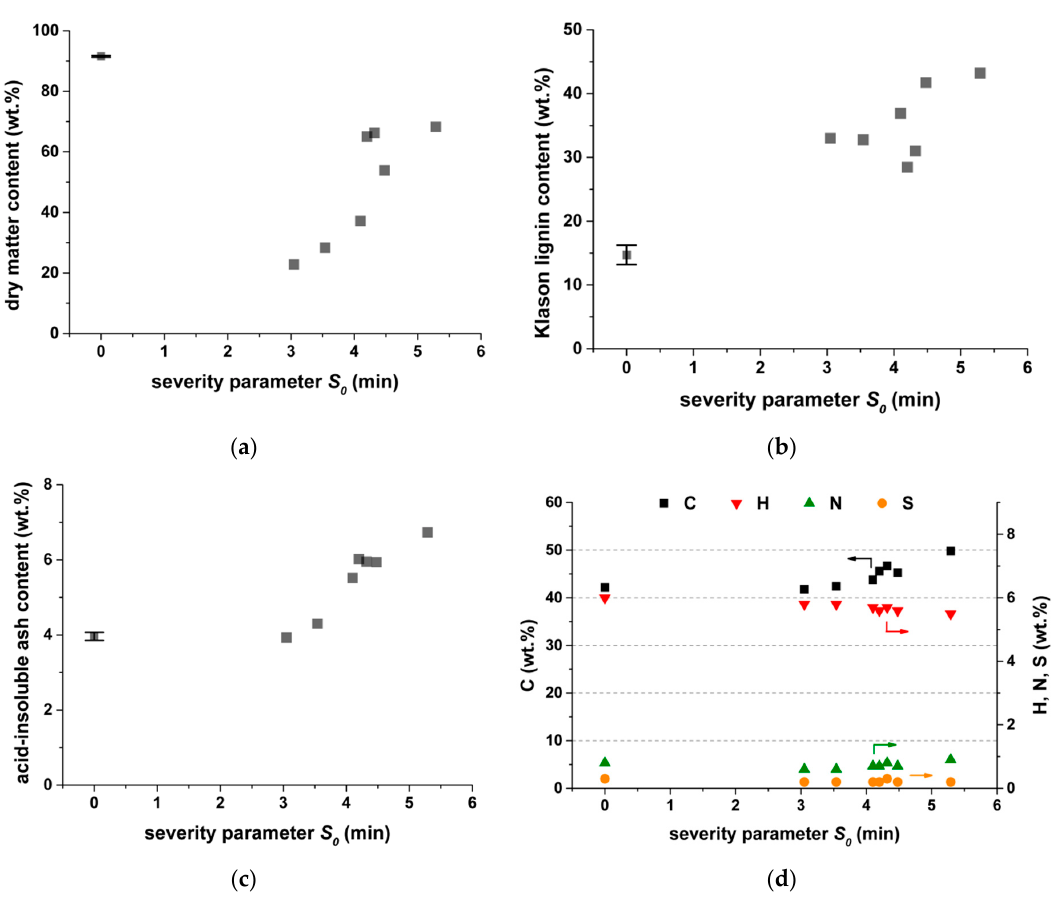
Figure 2. Chemical composition of untreated and pretreated rice straw depending on the severity parameter S 0 of the steam explosion, ( a ) dry matter content, ( b ) Klason lignin content, ( c ) acid-insoluble ash content, and ( d ) elemental composition.